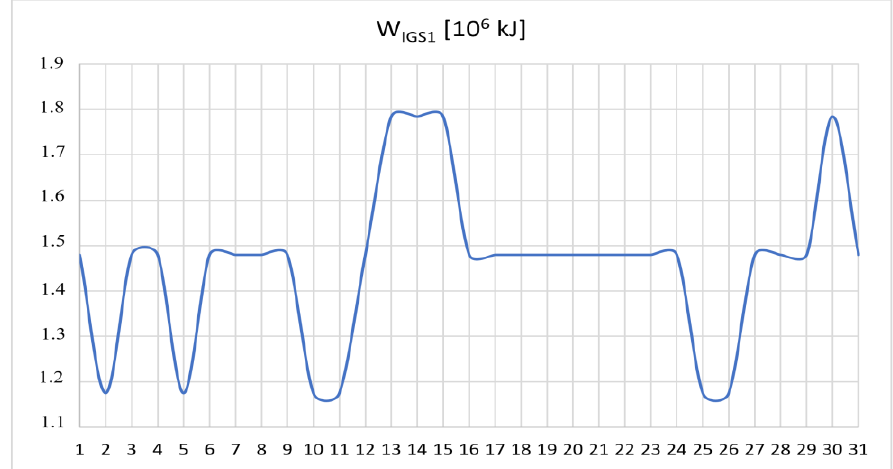
Energies 2023 , 16 , 174 Figure 7. TE daily consumption for TS1 [July 2019]. Figure 7. TE daily consumption for TS1 [July 2019].